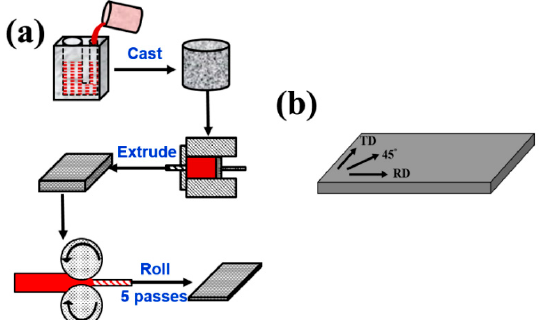
Figure 1. The preparation schematic of the ATM610 alloy sheet: ( a ) technological process and ( b ) machine directions.